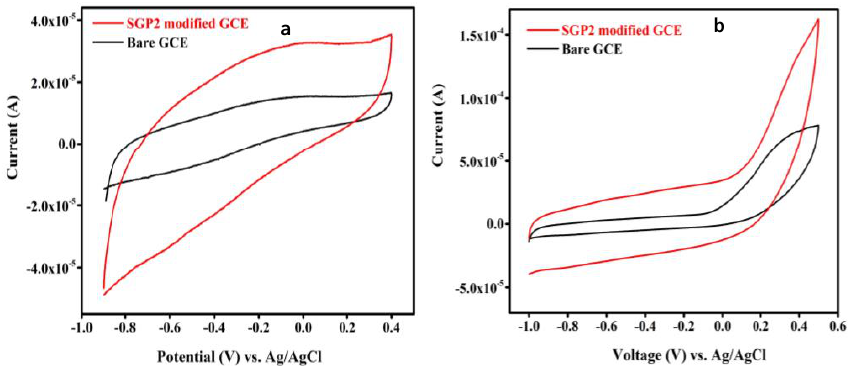
Figure 4. Cyclic voltammetry curves for ( a ) the absence of H 2 O 2 and ( b ) in the presence of 0.1 mM H 2 O 2 .